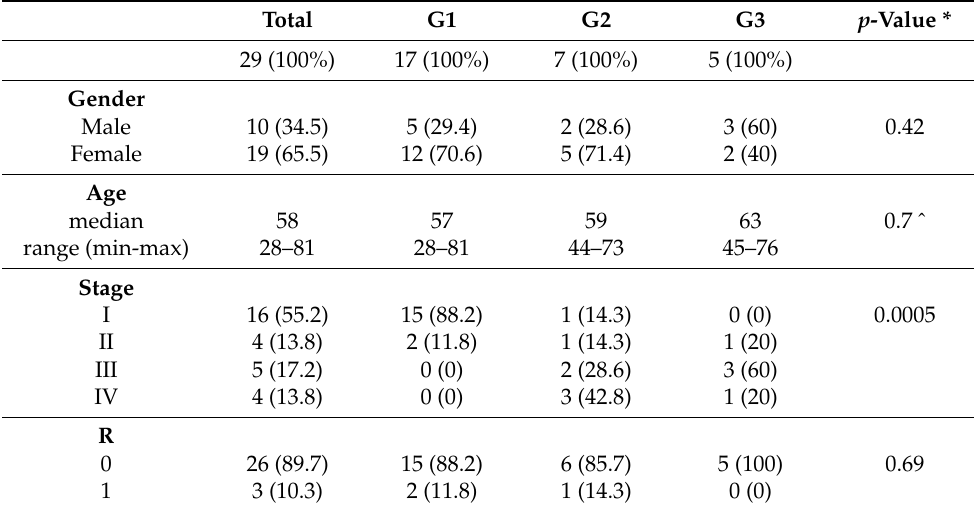
Table 1. Clinical-pathological characteristics of 29 PanNET patients grouped according to pathologi- cal